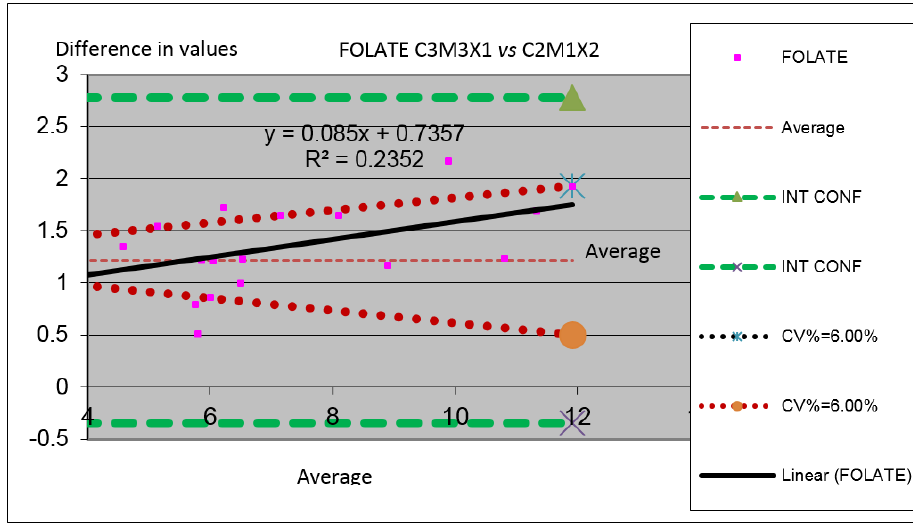
Figure 8. Comparison between modules for the Folate parameter in which we have compared the results obtained by the measurements performed in the two machines (Analyzer C3 substituted by C2 in which the Module 3 is substituted by the Module M1 and the Channel X1 is substituted by the Channel X2).